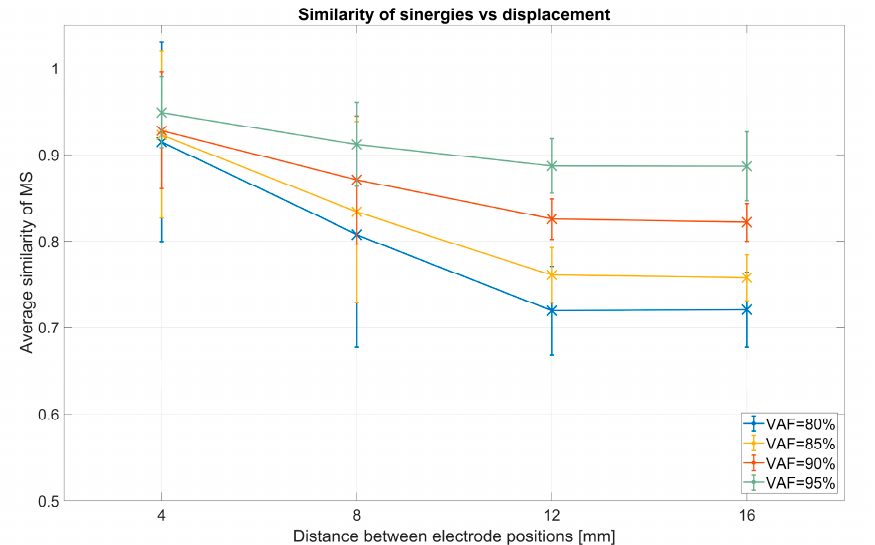
Figure 15. Intra-session muscle synergy (MS) similarity plotted against distance between electrodes: The graph clarifies the decreasing trend in synergy similarity when simulating increasing distance between